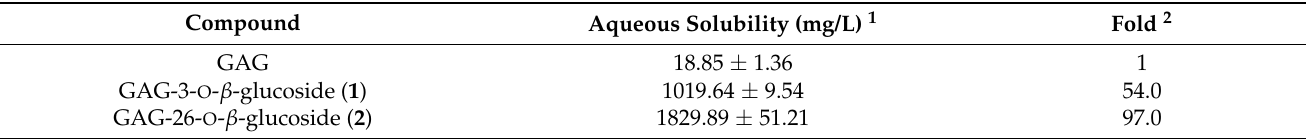
Table 2. Aqueous solubility of GAG and its derivatives at 25 ◦